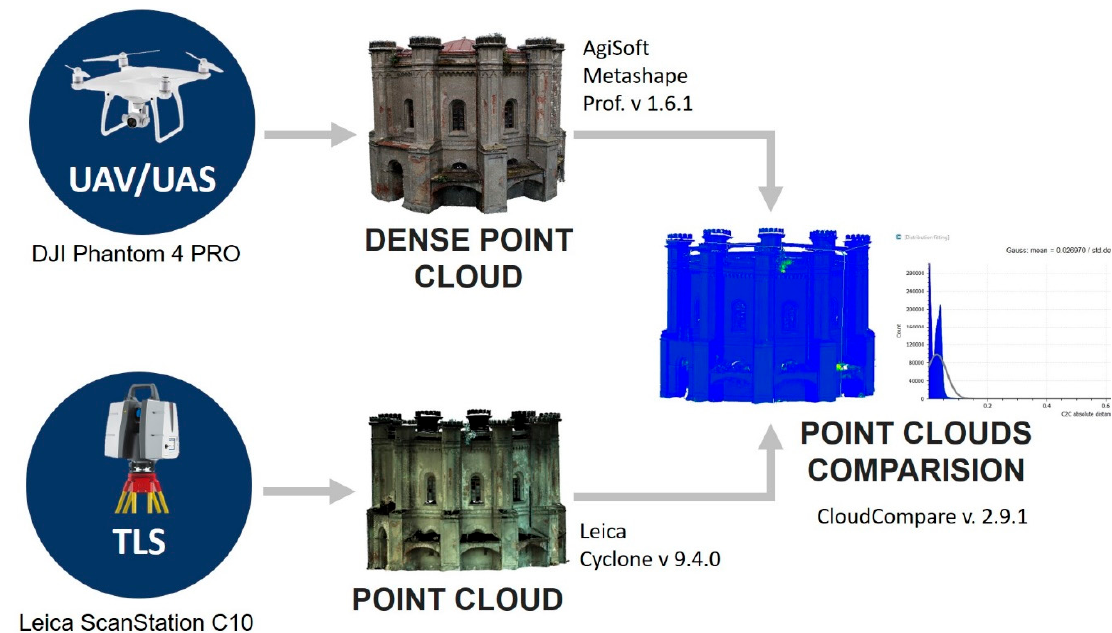
Figure 7. Methodology of UAV dense point cloud quality assessment.